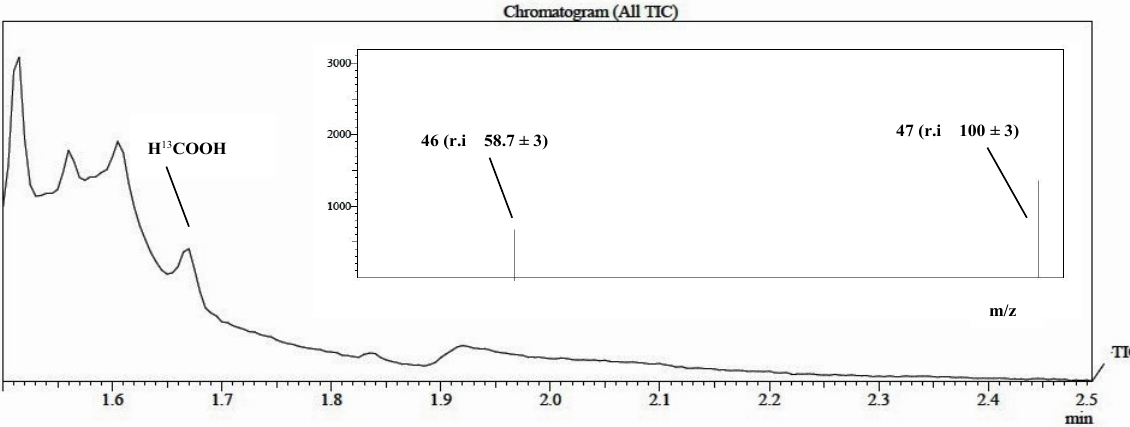
Figure 4 . Qualitative determination of formic acid performed by GC/MS in SIM Mode analyzing formic acid- 13 C obtained by photoreduction of NaHCO 3 13 C